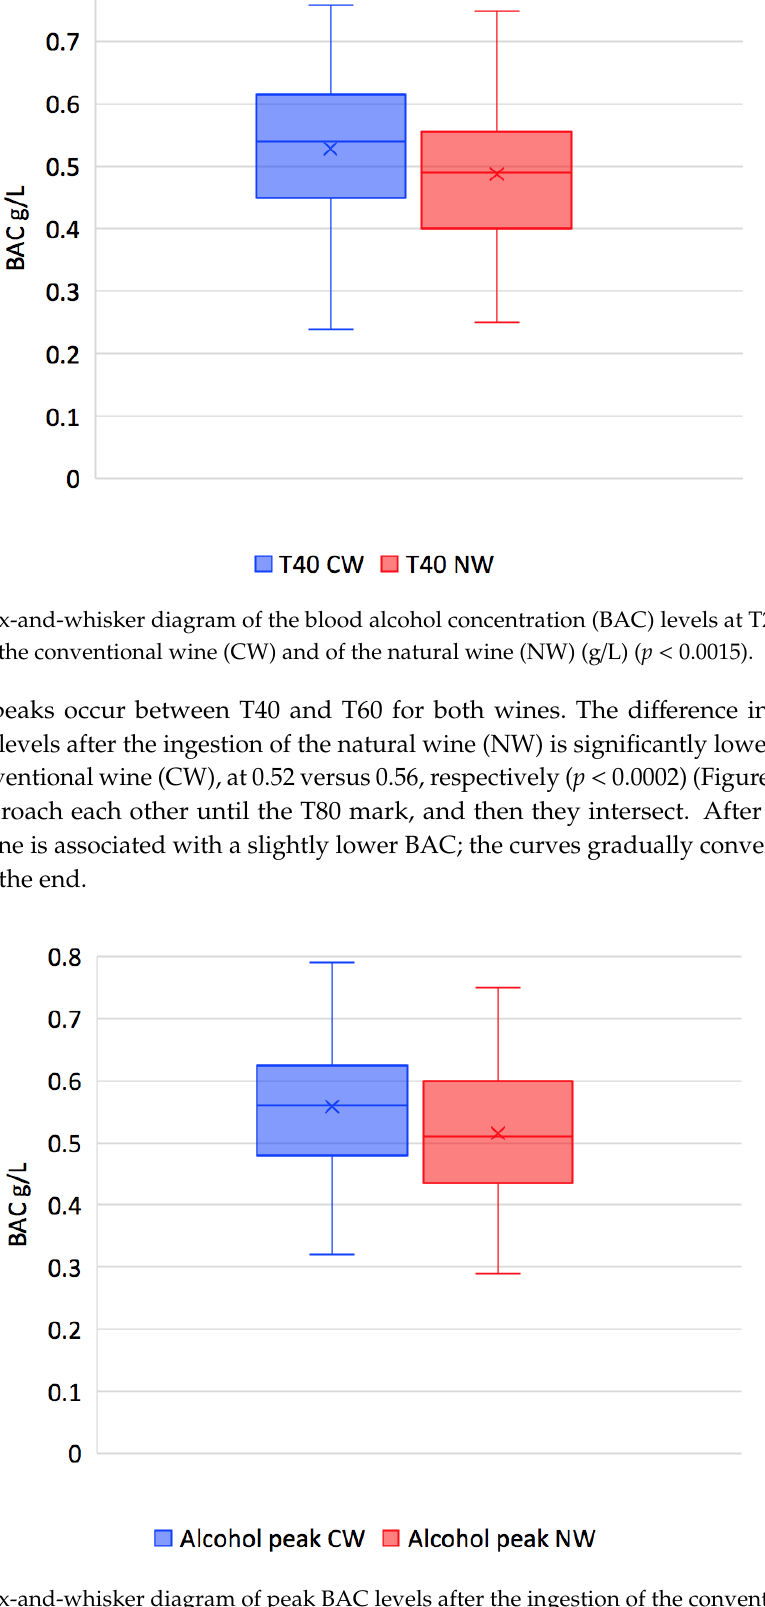
Figure 5. Box-and-whisker diagram of peak BAC levels after the ingestion of the conventional wine (CW) and of the natural wine (NW) (g/L) ( p < 0.0002).